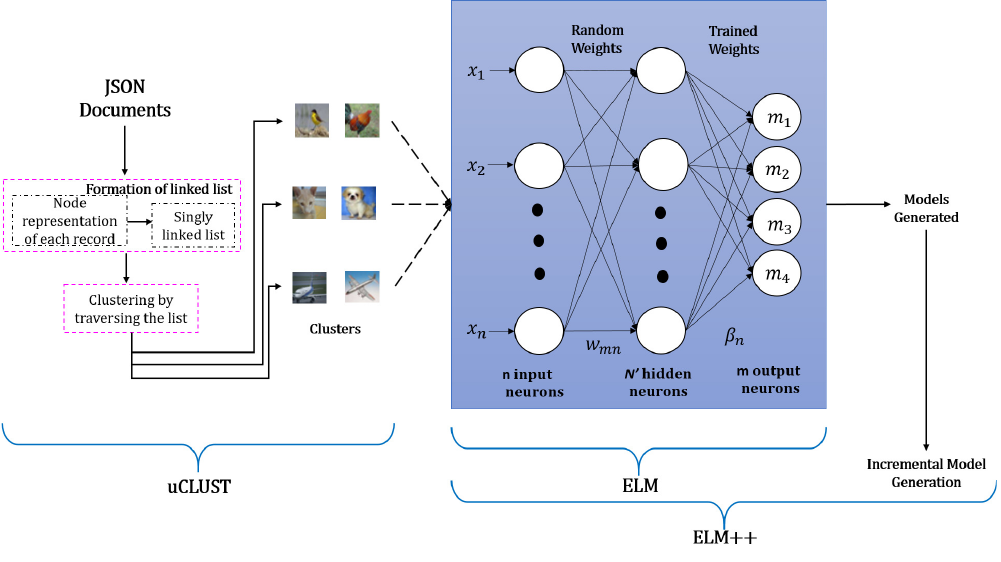
Figure 2. Architecture of CUIL